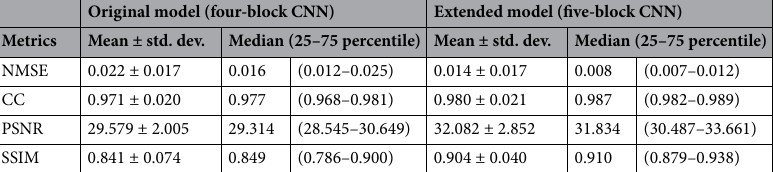
Table 4. Summary of testing the method over a synthetic dataset with multiple low-temperature heat